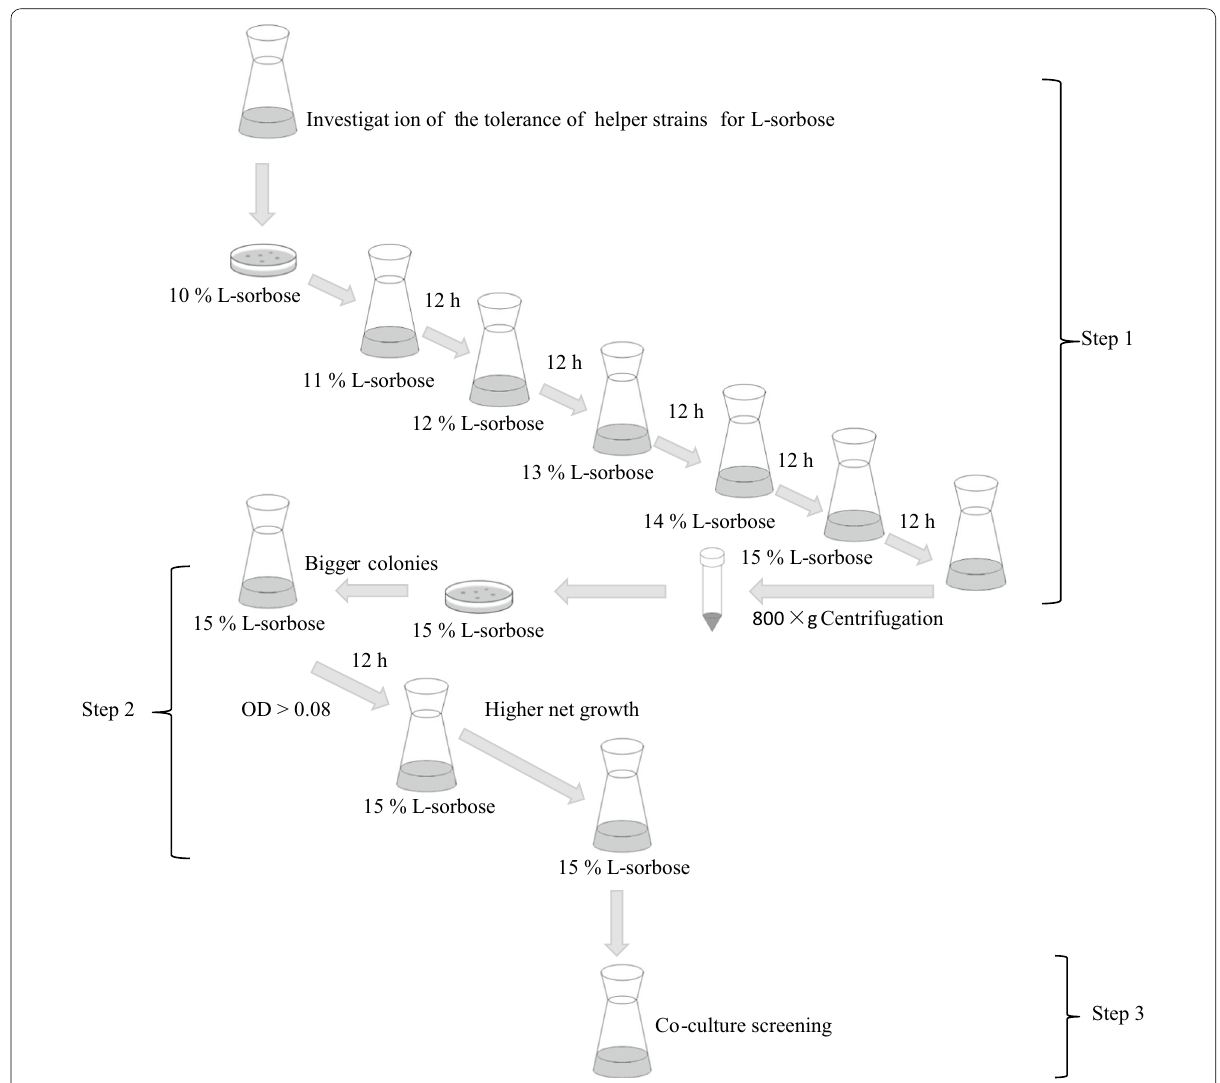
Fig. 2 The flow-process diagram for screening l -sorbose-tolerant helper